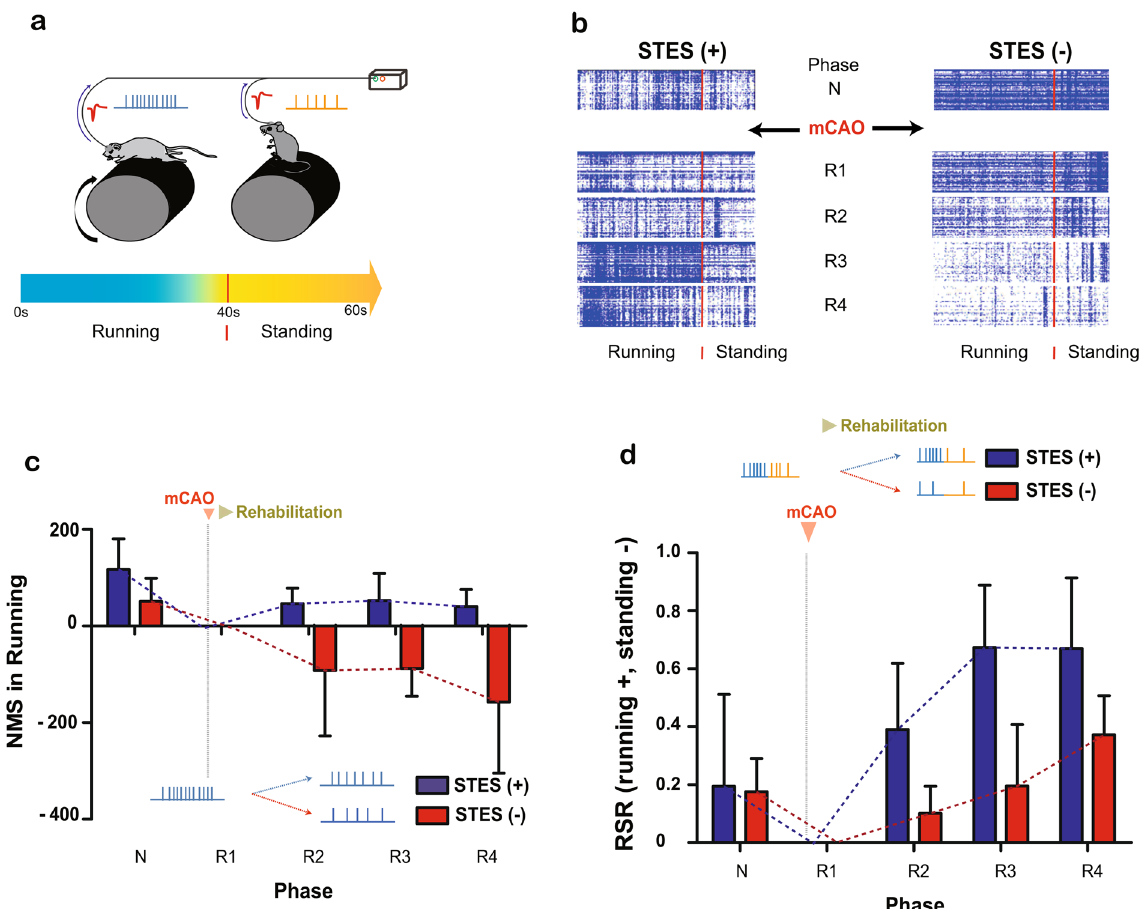
Figure 5. Physiological analysis. ( a ) The neural spike signal was measured while a rat was running and standing for 40 and 20 s, respectively. ( b ) The spike firing in the mCAO STES( +) and mCAO STES(-) groups is shown in the daily raster plot for each phase (N, R1, R2, R3, and R4; pre mCAO, less than 5 days, 10 days, 15 days after the mCAO, and more than 15 days after mCAO, respectively). ( c ) The NMS in the running state; the NMS for mCAO STES( +) group does not change, while the NMS for the mCAO STES(−) group decreases after mCAO (two-way ANOVA; interaction, ns; group, * p < 0.05, F(4,40) = 6.9). ( d ) The RSR on the rotarod; neural firing activation for the mCAO STES( +) group was focused more on the running task after the mCAO (two-way ANOVA; interaction, ns; group, * p < 0.05, F(1,44) = 5.22; phase, * p < 0.05, F(4,44) =